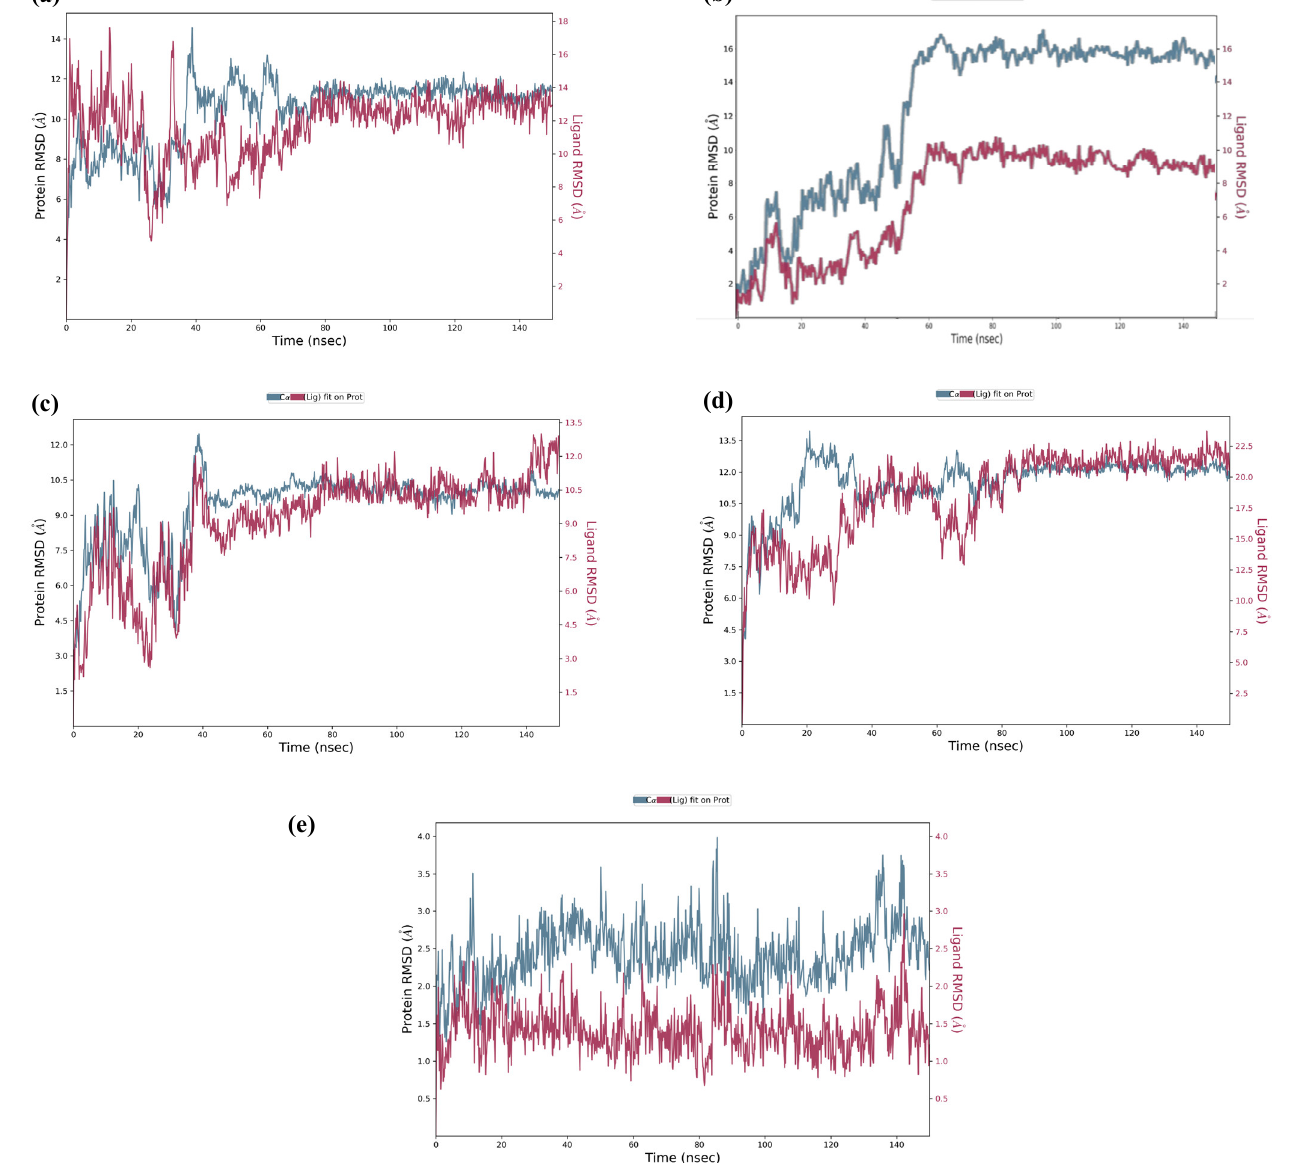
Figure 4. Molecular simulation RMSD trajectories with respect to time. The MD simulation was done for 150 ns at 310 K temperature, 1.00314 bar pressure, 1000 frames, and 7.4 pH). The MD simulation of the docked complex of GSTR–capsid protein ( a ); TDGH–capsid protein ( b ); LEEV–capsid protein ( c ); WDDG–capsid protein ( d ); EGDE–capsid protein ( e ). The left Y-axis shows the variation of protein RMSD through time. The right Y-axis shows the variation of ligand RMSD through time.